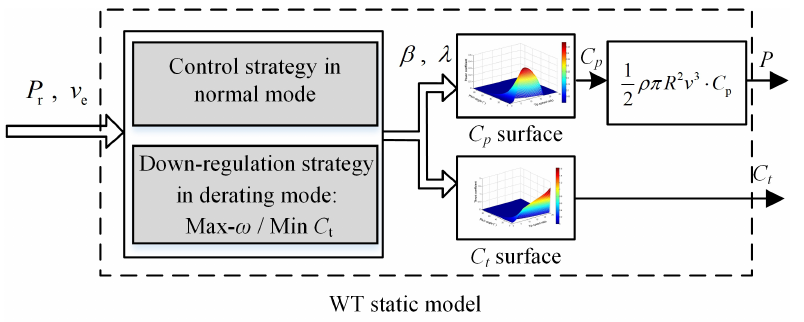
Figure 1. Wind turbine static model, where P r is the power reference of the WT, v e is the effective wind speed, β is the pitch angle, λ is the tip speed ratio, C p is the coefficient of the power, ρ is the air density, R is the radius of the rotor of the turbine, and P is the power